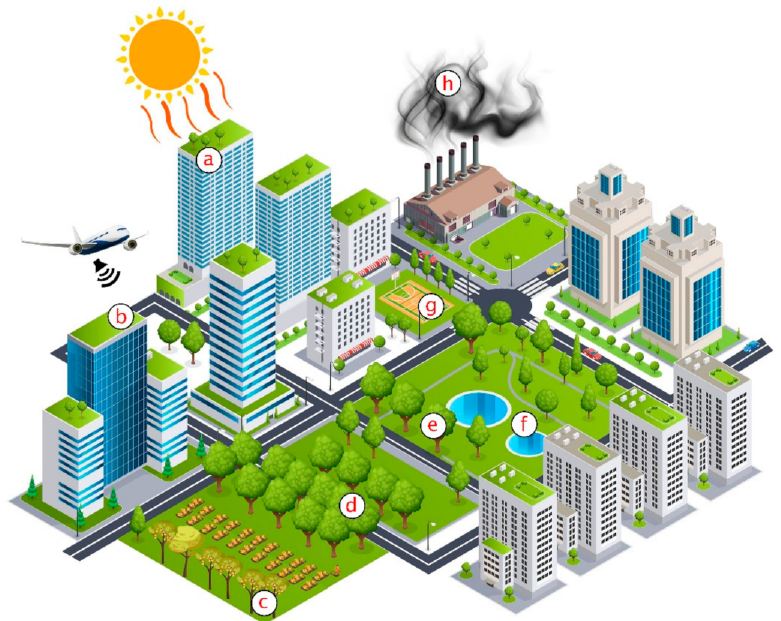
Figure 1. Ecosystem services provided by green and blue infrastructure: ( a ) regulation of micro- climate, ( b ) noise reduction, ( c ) food production, ( d ) carbon storage and sequestration, ( e ) habitat provision, ( f ) run-off retention and water filtration, ( g ) recreational and cultural values, and ( h ) air purification (image modified from